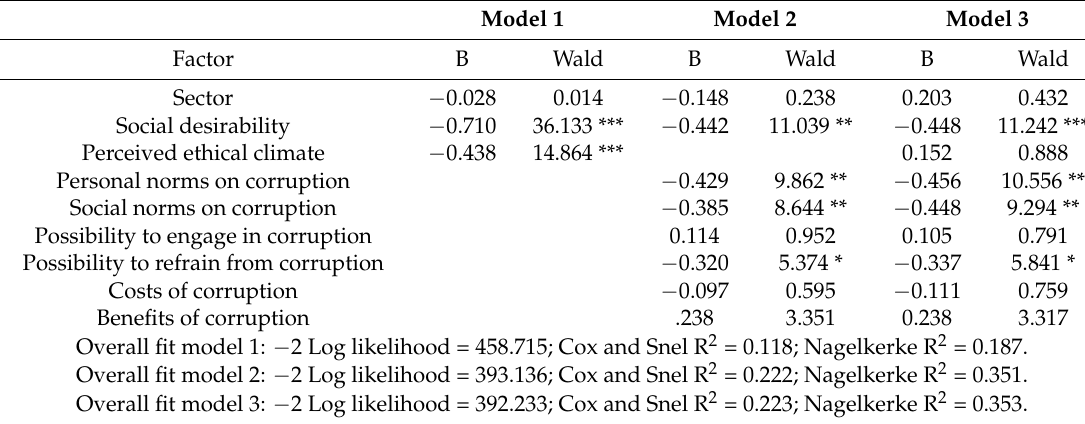
Table 3. Binary logistic regression model of corruption-proneness (corruption-prone = 1, not corruption-prone = 0; n = 523).